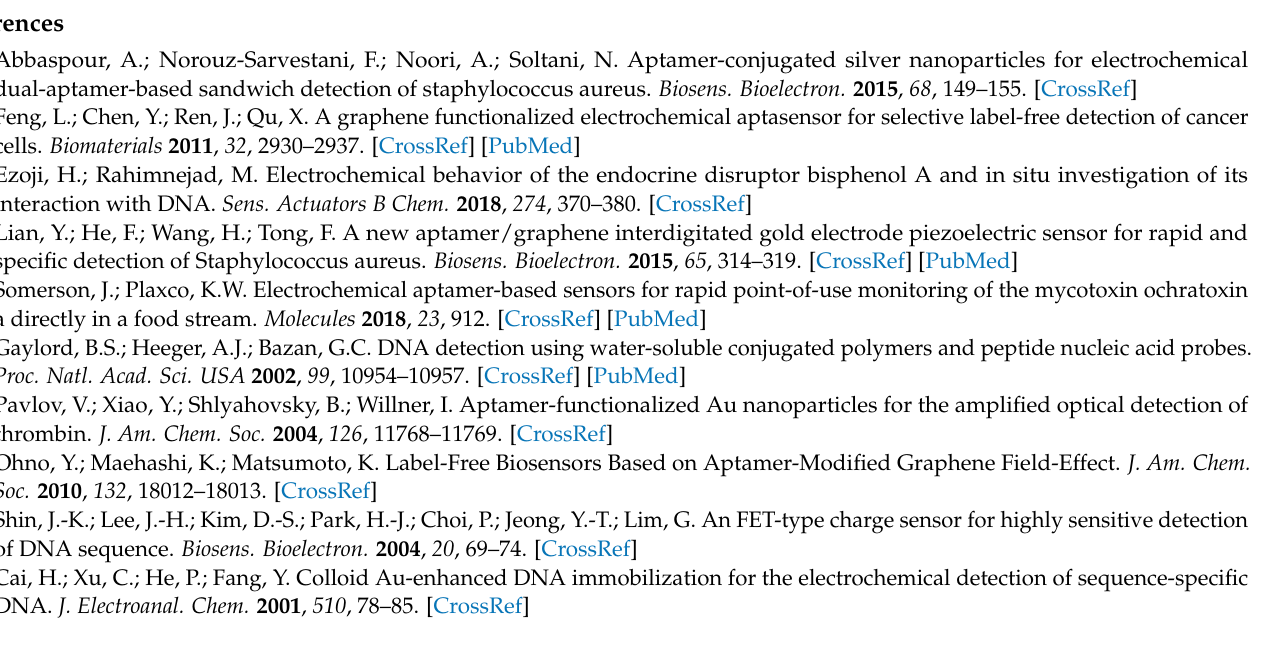
with DI water.; Figure S2: Determination of hybridization time. (a) Sixteen UV absorption curves measured every 30 s for 480 s. (b) Absorbance at a wavelength of 260 nm as a function of time; Figure S3: (a) Nyquist plot for the different accumulation times at 0.26 V from 1 min to 15 min. (b) R ct value as a function of time. The sample PBS solutions contained 1 nM probe DNA and 4 mM [Fe(CN) 6 ] 3 − /4 − .; Figure S4: (a) Schematic and (b) image showing the integration of the three electrodes platform.; Figure S5: Cyclic voltammetry responses of the F-MWCNT/MWCNT/PDMS electrode after 1 cycle and after 100 cycles. The electrode was immersed in PBS solution containing 4 mM [Fe(CN) 6 ] 3 − /4 − . Table S1: Fitted values of the equivalent circuit parameters from dark Nyquist plots of devices without and with 5%